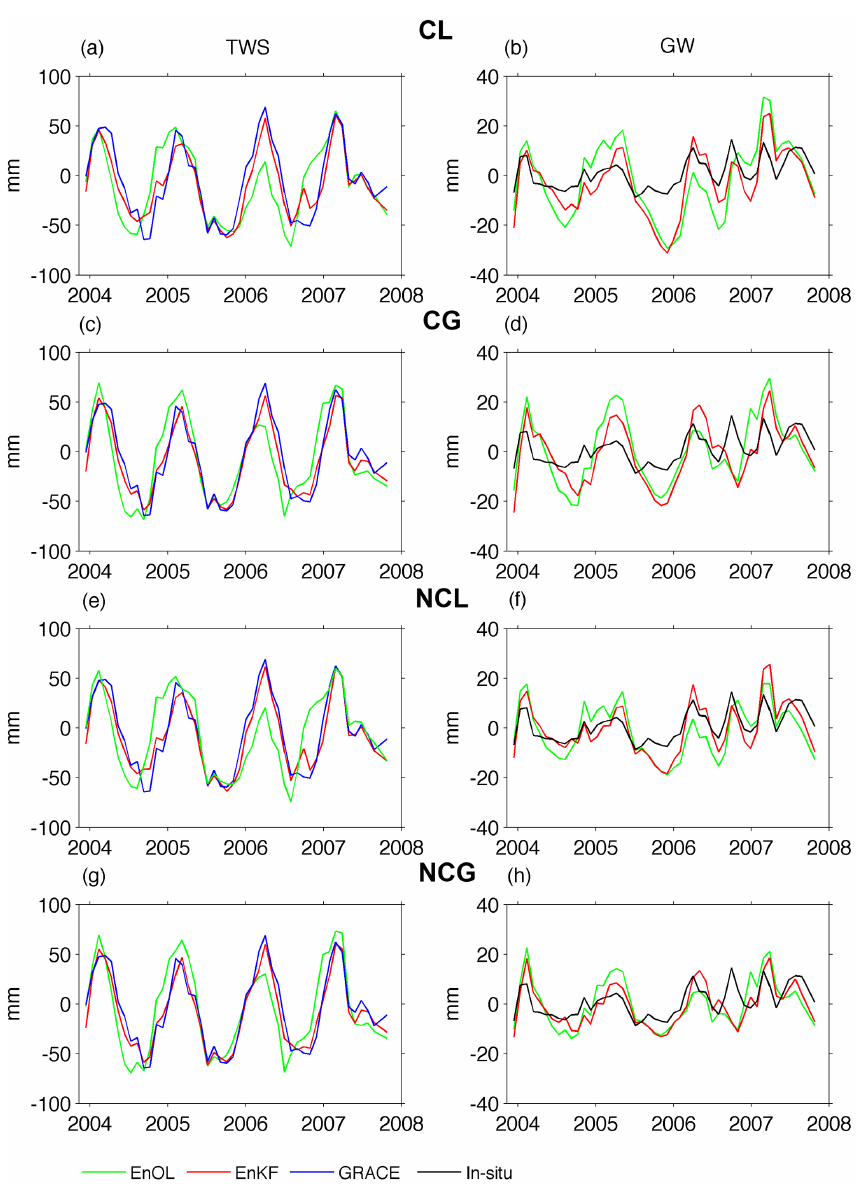
Figure 8. TWS variation (left panels) and GW variation (right panels) at the A319C well location in four different scenarios (CL: calibrated parameters with local forcing data; CG: calibrated parameters with global forcing data; NCL: non-calibrated parameters with local forcing data; NCG: non-calibrated parameters with global forcing